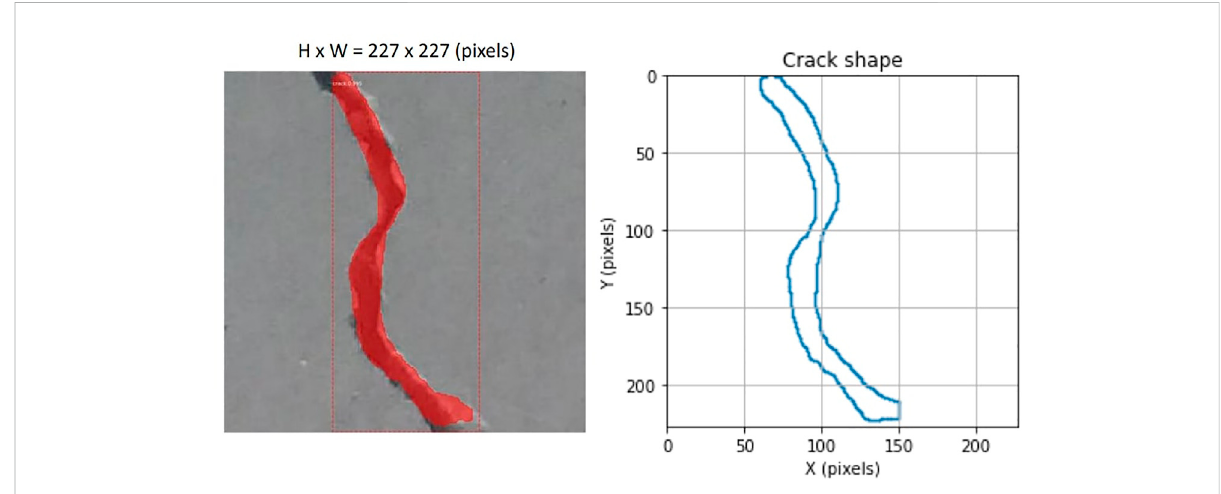
FIGURE 6 Crack shape reconstruction in the image